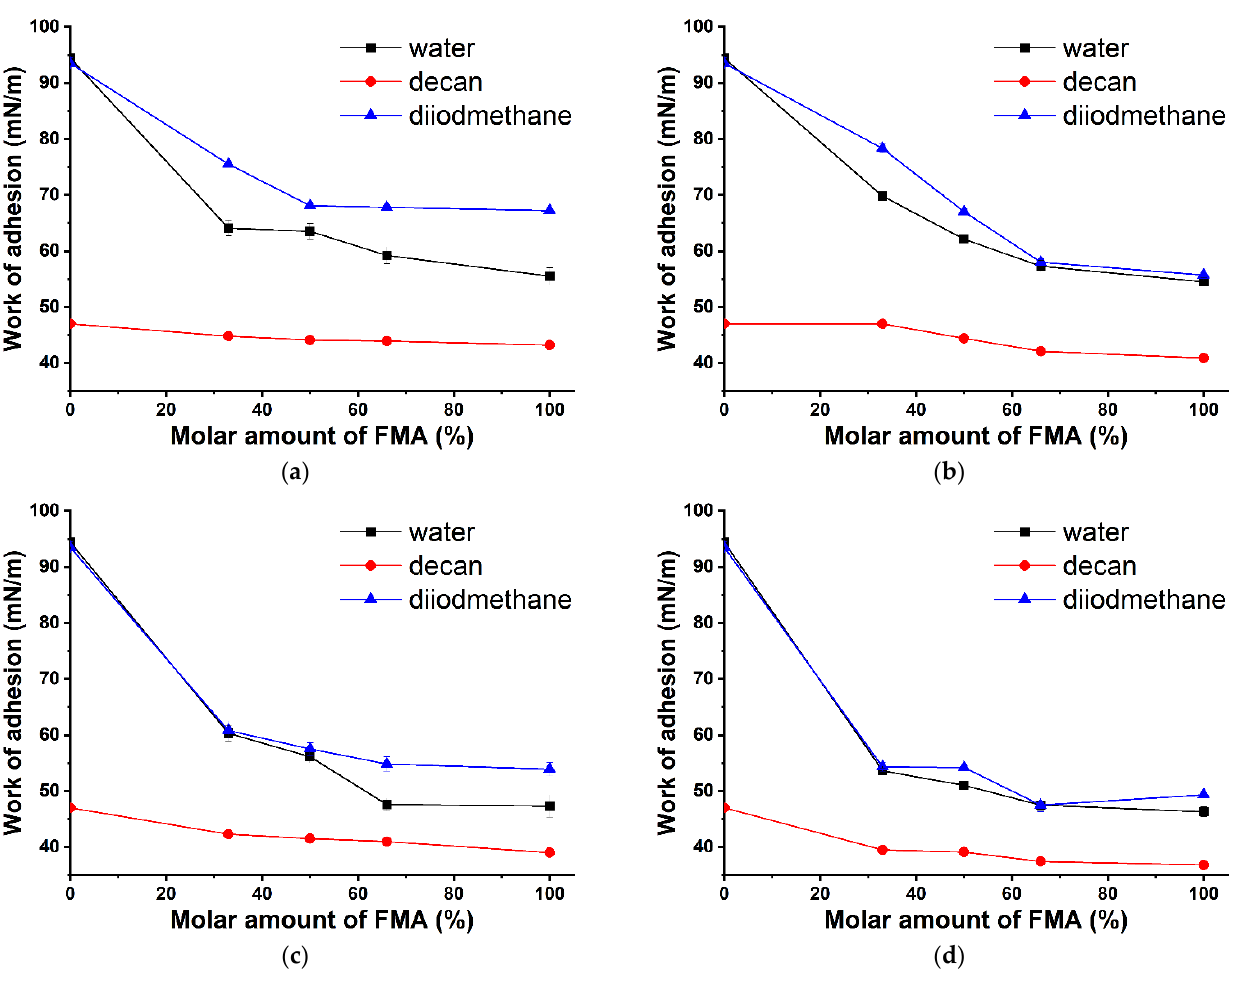
Figure 1. Change in the work of adhesion of the test liquids (water, n-decane, and diiodomethane) on the surface of glasses modified with FMA- and GMA-based copolymers as a function of the FMA content in the copolymer: ( a ) poly-(TEMA-co-GMA); ( b ) poly-(HFMA-co-GMA); ( c ) poly-(HIMA-co-GMA); ( d ) poly-(HBMA-co-GMA).